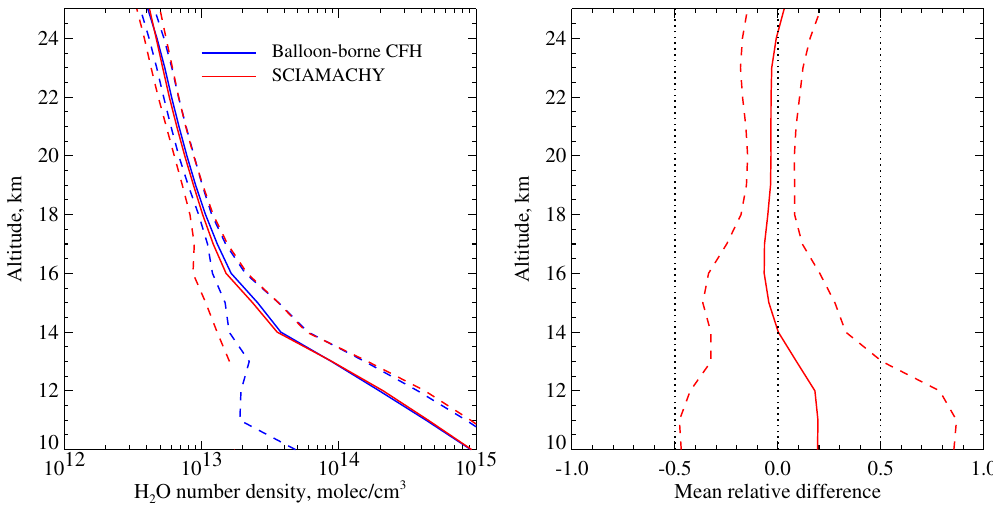
Fig. 20. Comparison to in situ balloon-borne observations. Left panel: solid lines show balloon-borne CFH (blue) and SCIAMACHY (red) profiles averaged over all balloon launches at all locations as shown in Fig. 19 whereas dashed lines depict corresponding standard deviations. Right panel: mean relative difference between SCIAMACHY and balloon-borne CFH results (solid line) and corresponding standard deviation (dashed